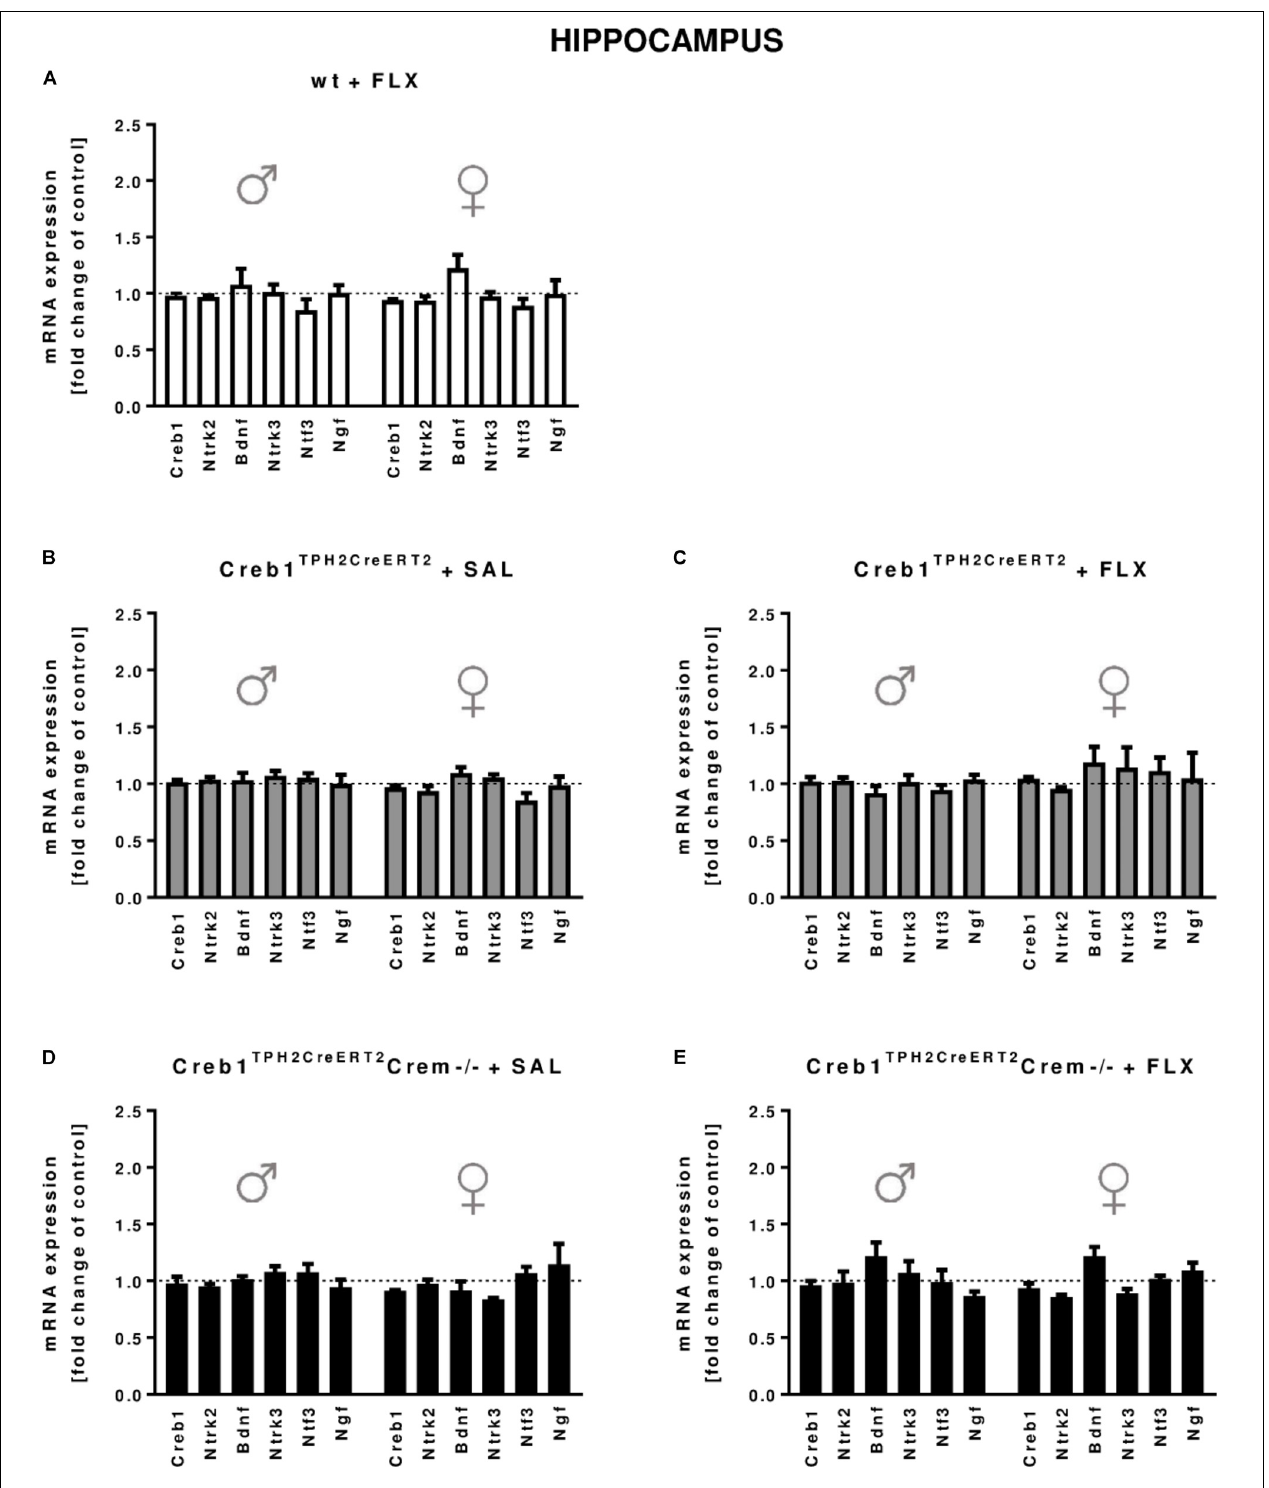
FIGURE 2 | mRNA expression of genes encoding for Creb1, neurotrophins (Bdnf, Ngf, and Ntf3) and their receptors (Ntrk2, Ntrk3) in the hippocampus of saline- and fluoxetine-treated wild-type, Creb1 TPH2CreERT2 , and Creb1 TPH2CreERT2 Crem–/– mice. Neither genotype nor fluoxetine influenced the mRNA expression of Creb1, Bdnf, Ngf, Ntf3, Ntrk2, and Ntrk3. Bars represent fold changes in the mRNA expression of Creb1, Bdnf, Ngf, Ntf3, Ntrk2, and Ntrk3 vs. that in wild-type non-treated animals (dot line) in the hippocampus of (A) wild-type fluoxetine-treated, (B,C) Creb1 TPH2CreERT2 saline- and fluoxetine-treated, and (D,E) Creb1 TPH2CreERT Crem–/– saline- and fluoxetine-treated mice. All graphs show data from males (left) and females (right). W/t, wild-type; FLX, fluoxetine. Data are presented as the mean ± SEM.